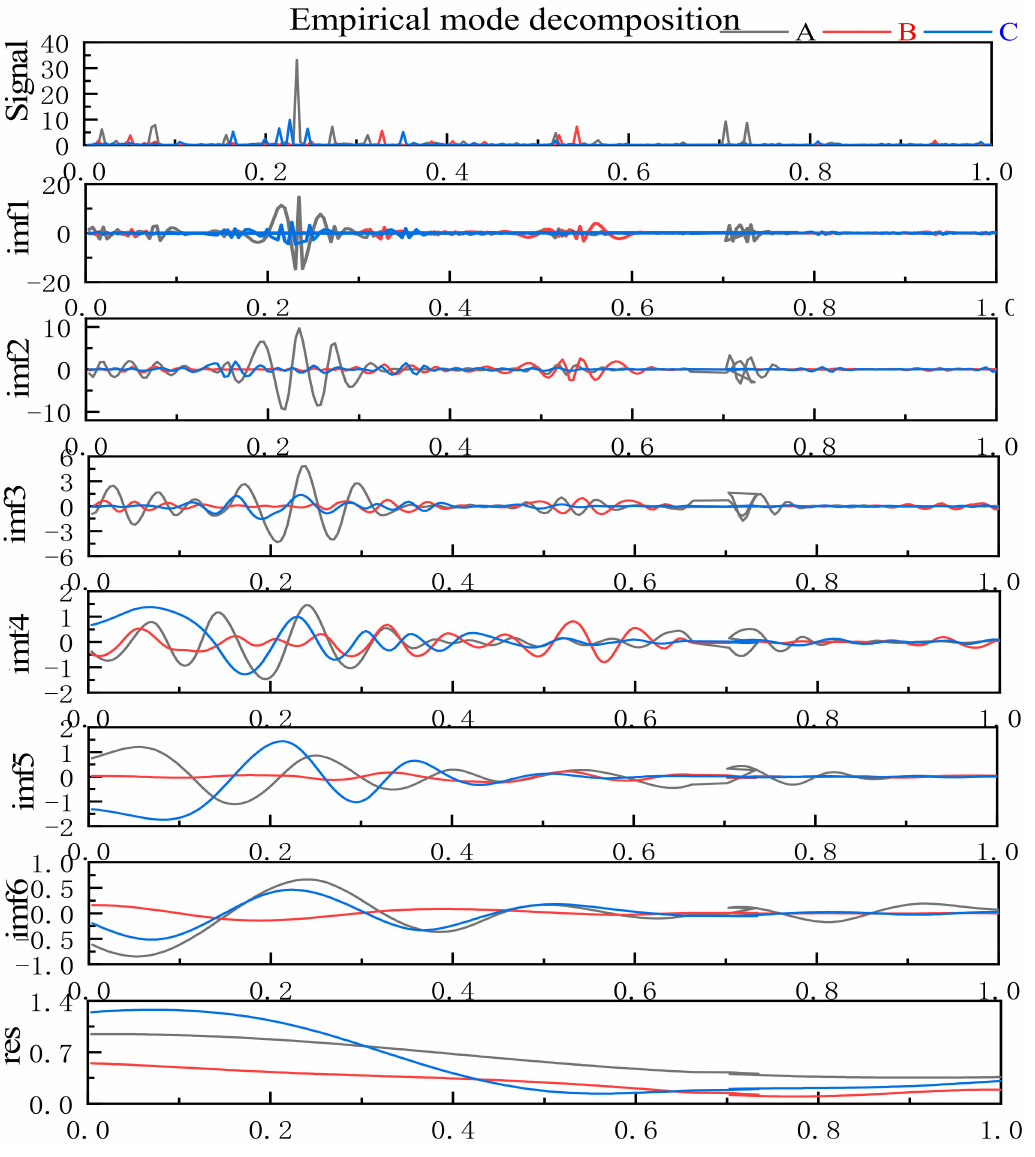
Figure 10. Empirical mode decomposition of AE signals for samples ( A ) B-V1, ( B ) B-V2, and ( C )